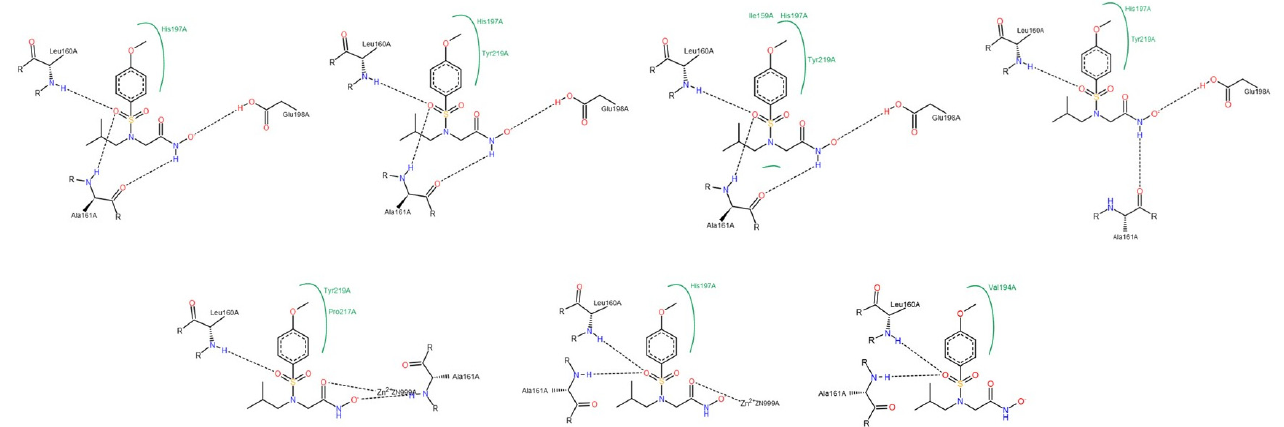
Figure A3. Interactions between NNGH inhibitor and MMP-8, by PoseView calculations.